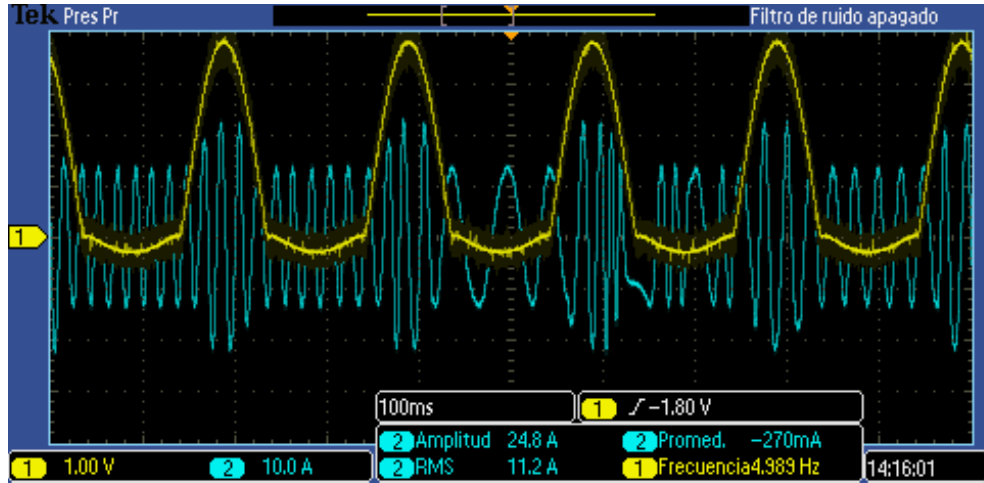
Figure 22. Motor current behavior after locking the motor by means of the brakes.